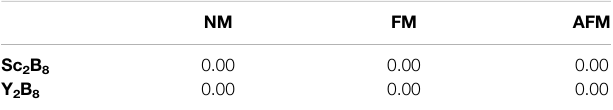
TABLE 1 | Relative energies of Sc 2 B 8 and Y 2 B 8 clusters with different magnetic con fi gurations (in